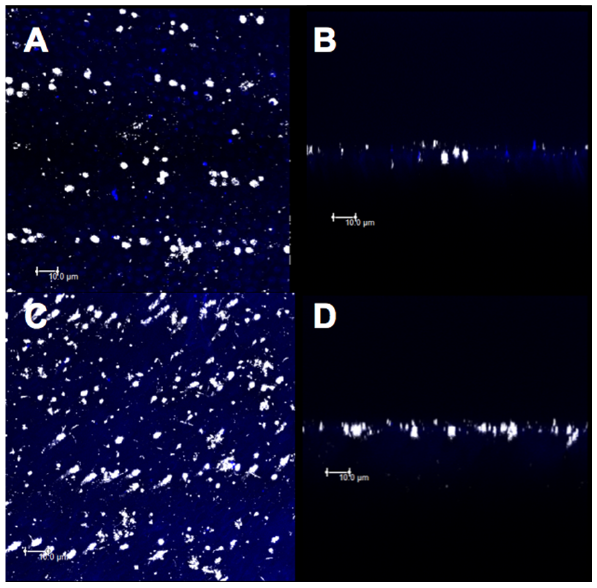
Figure 10. Confocal laser scanning microscopy images (fluorescence mode) in XY and XZ axis of dentin surface. ( A , B ) Fluoride varnish without nanofiber and ( C , D ) after 6% citric acid challenge.